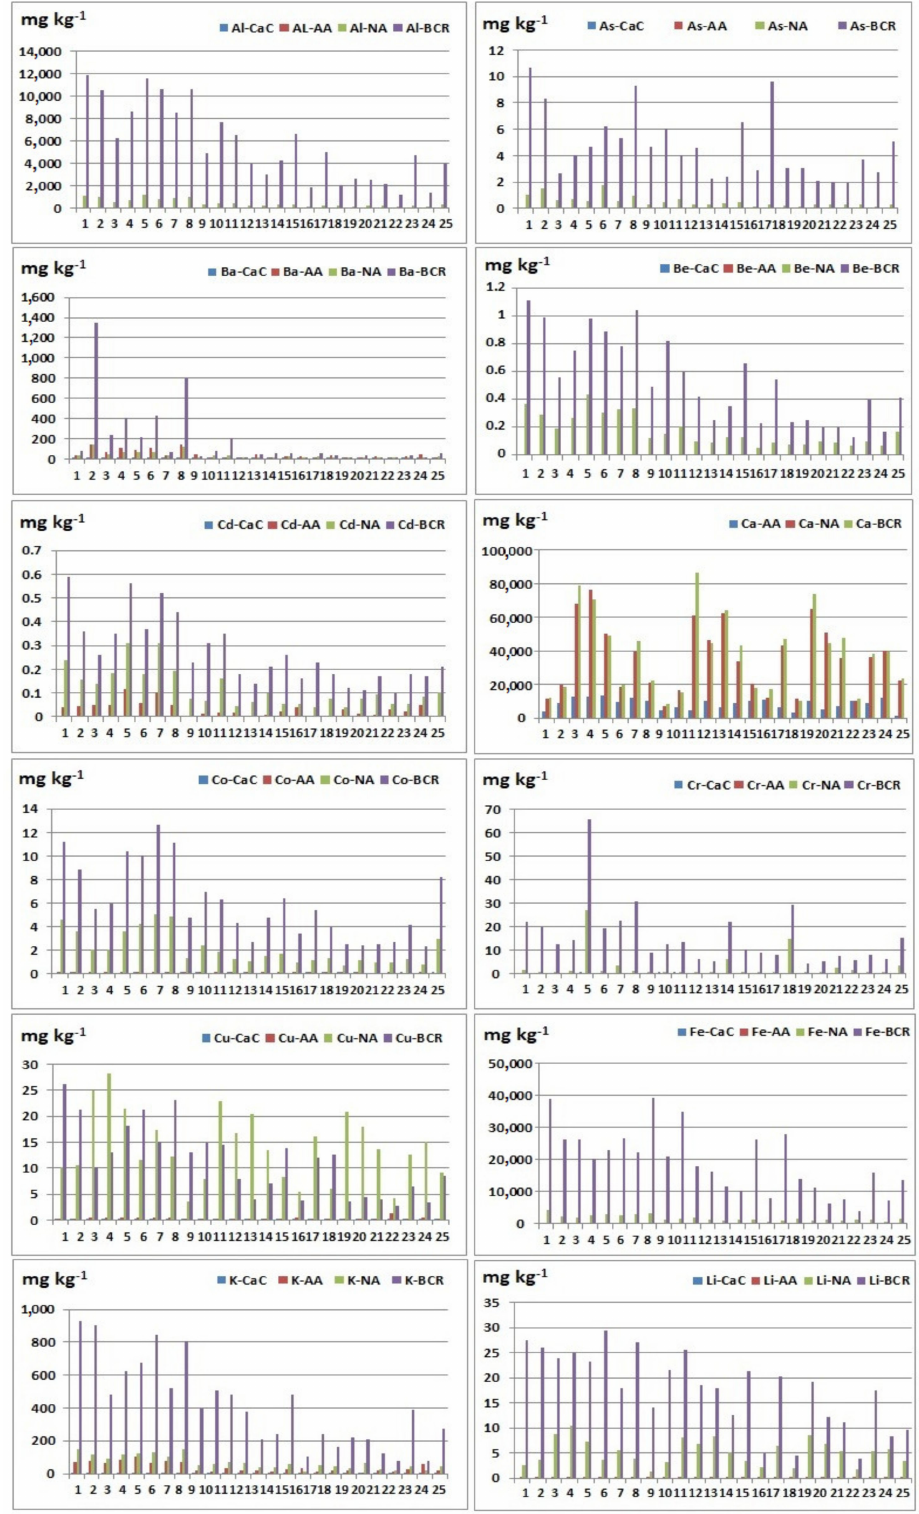
Figure 2. Extracted element contents (Al, As, Ba, Be, Cd, Ca, Co, Cr, Cu, Fe, K, and Li) using different reagents: CaC—calcium chloride; AA—ammonium acetate; NA—nitric acid; BCR—total element content (extracted element using BCR extraction